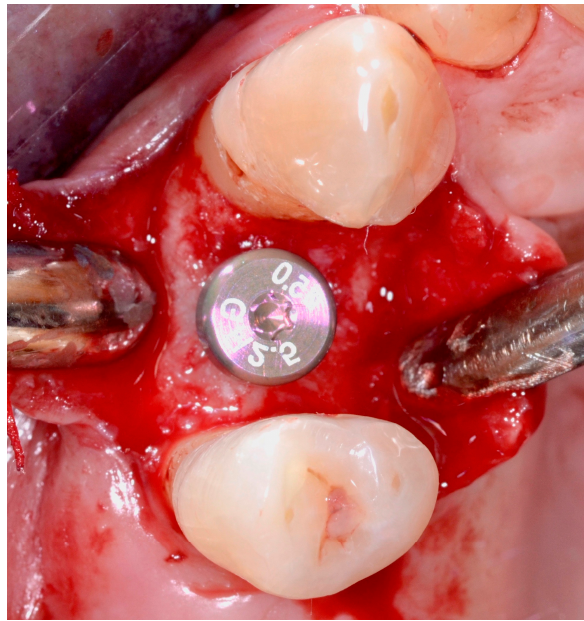
Figure 8. Implant placement.